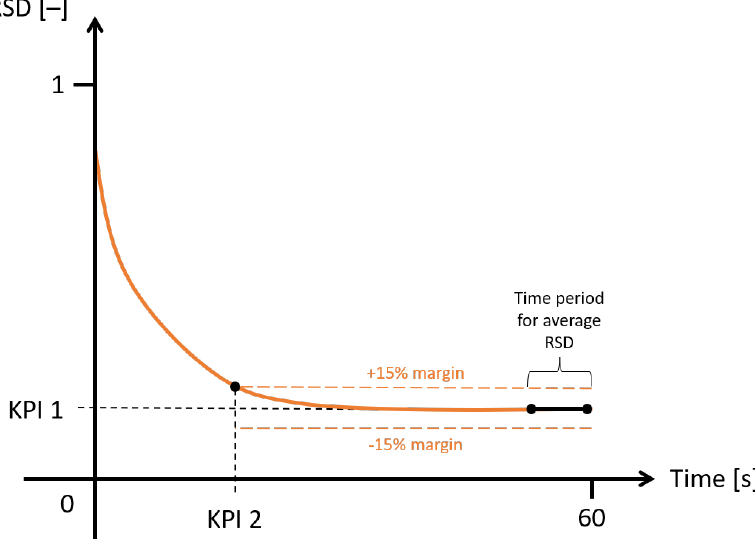
Figure 2. Illustrations of factor levels: ( a ) composition, ( b ) initial filling pattern (FB = Front-Back, TB = Top-Bottom), ( c ) fill level, ( d ) paddle size, ( e ) paddle angle and ( f ) paddle number.